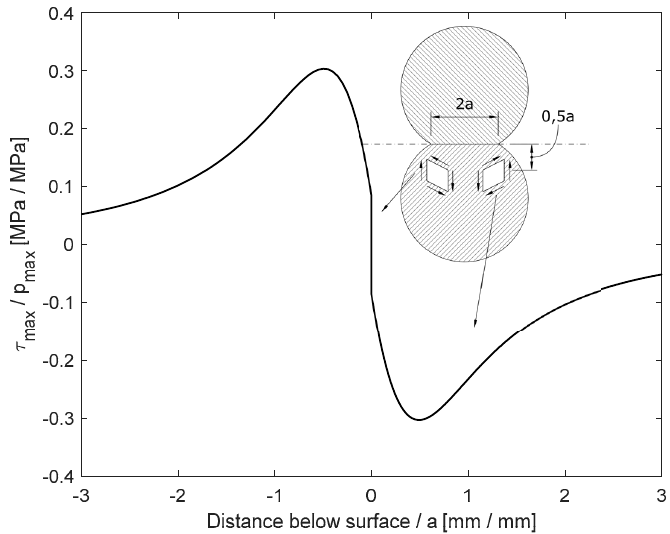
Figure 6. The tangential stress after and before rolling contact.